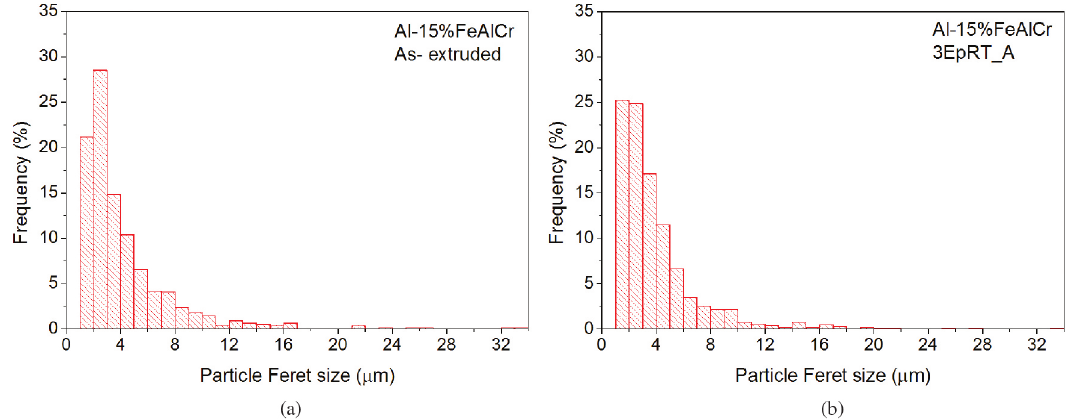
Figure 3. Histograms showing FeAlCr particle size distribution in as-extruded and after 3 ECAP passes at room temperature by route